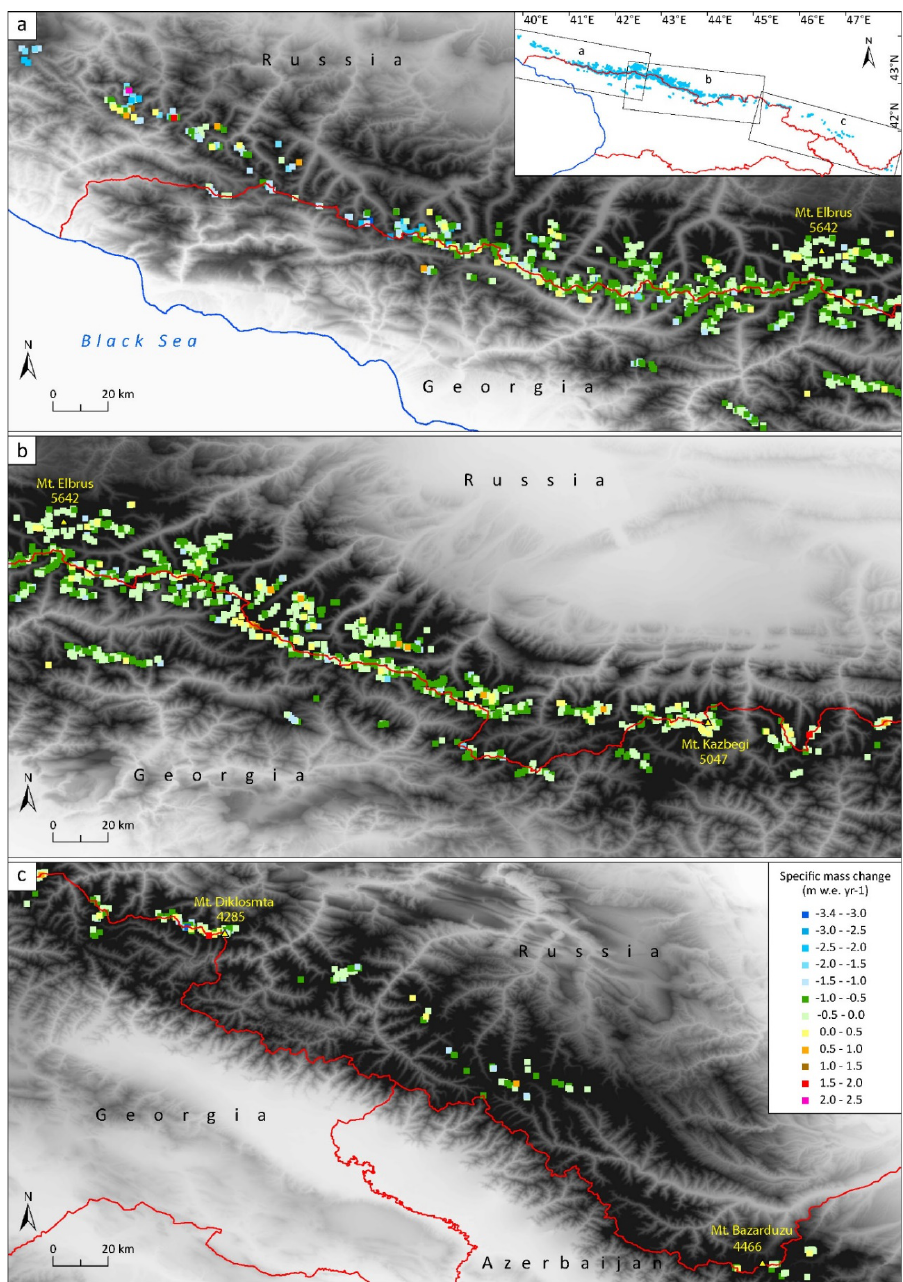
Figure 5. Changes in mean annual geodetic mass balance (m w.e. a −1 ) (color coded) for western ( a ), central ( b ), and eastern ( c ) Greater Caucasus glaciers in 2000–2019.